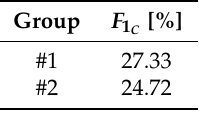
Table 4. Percentages of clearance of the first Fresnel zone for each test